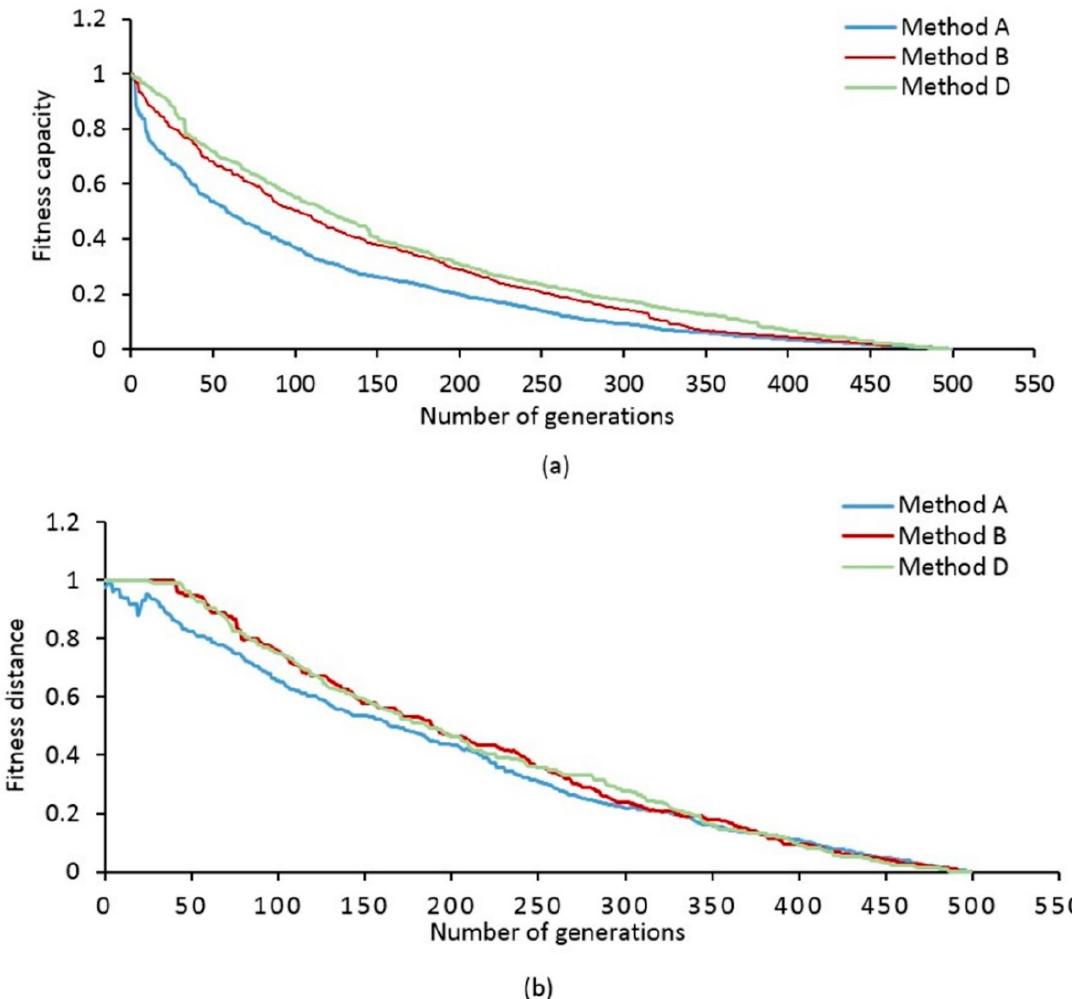
Figure 9. Fitness variation in the best values with number of generations. ( a ) Fitness value of capacity function, and ( b ) distance function found by methods A, B, and D.